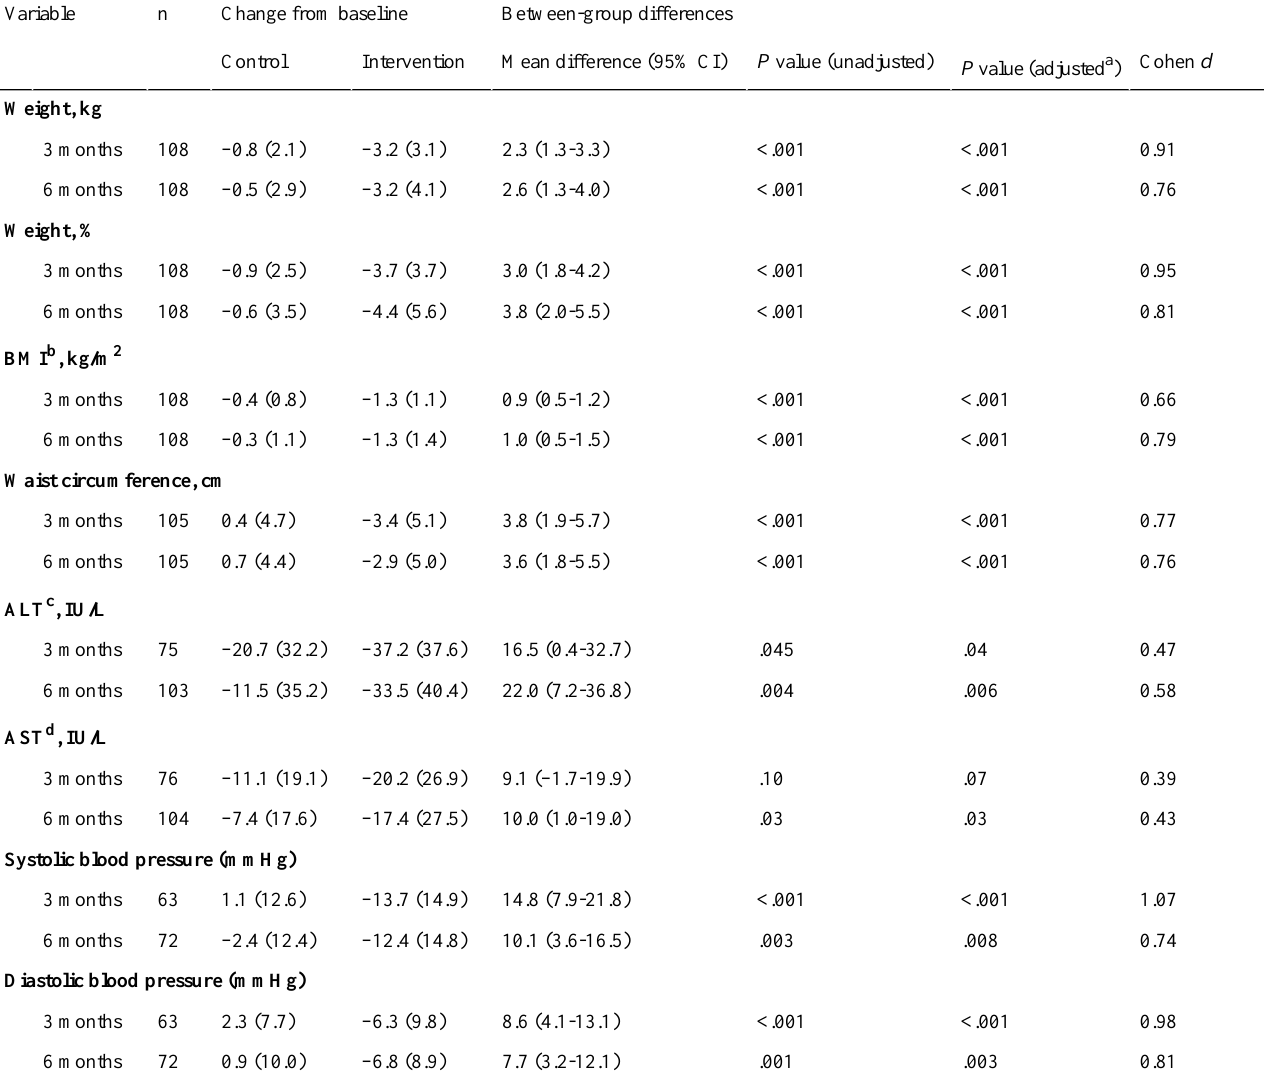
Table 3. Mean (SD) changes in anthropometric, biochemical, and clinical outcomes in patients with nonalcoholic fatty liver disease from baseline at 3 and 6 months after enrolment based on intention-to-treat analysis. Between-group differencesChange from